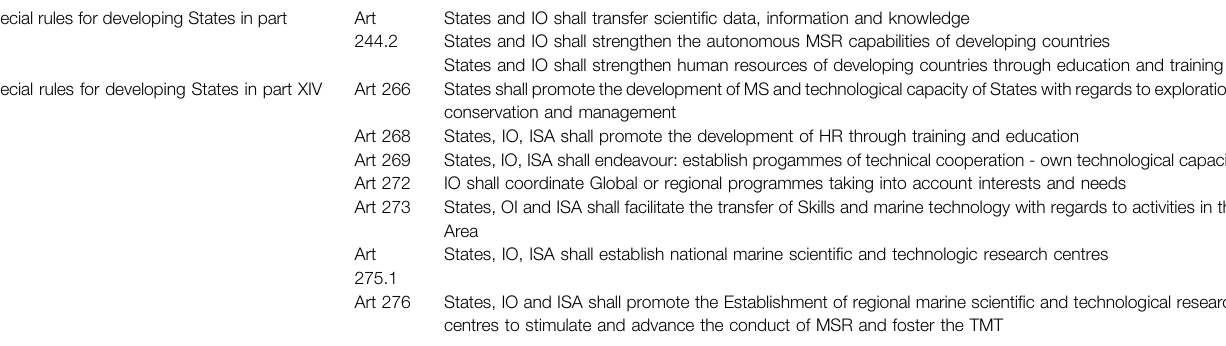
TABLE 1 | Law of the Sea Convention provisions in part XIII and part XIV (Development and transfer of marine technology) speci fi cally dealing with developing countries. Special rules for developing States in part